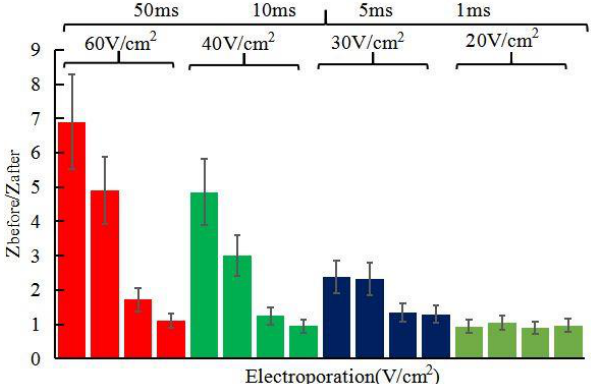
Figure 7. Effect of different pulse voltage and width pulsed-monophasic electric waveform of electroporation on the ratio of pre-experimental to post-experimental skin impedance ( Z before / Z after ). All skin impedance measurements were conducted at 100 Hz. For the electroporation setting, they all have the number of pulses per second of 10. Sensors 2018 , 18 , x